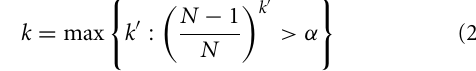
each state represents an alignment of N seeds, one from each protein